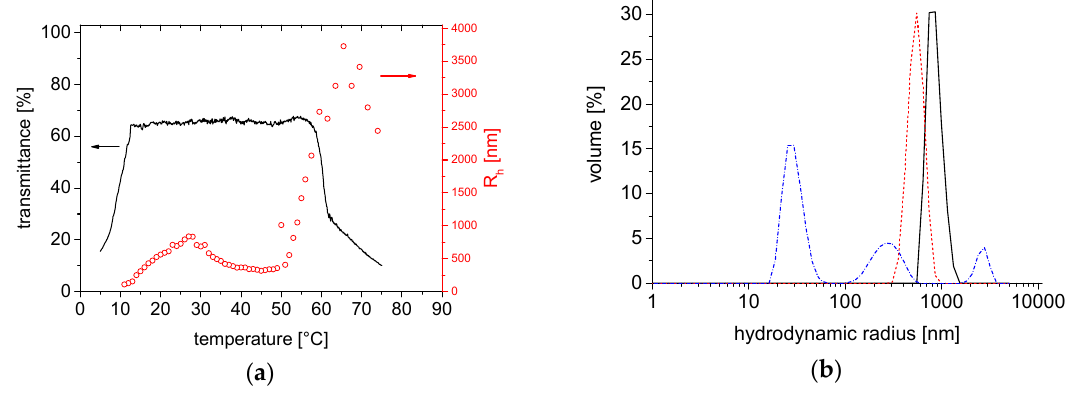
Figure 7. Temperature dependent study (cooling run) of 3.0 g·L − 1 solutions in NSS of ZPE-based block polymer PEG- b -PZPE-1: ( a ) by turbidimetry (cooling run); values for the apparent average hydrodynamic radius R h are also shown ( O ); ( b ) distributions of the hydrodynamic radii at 11 °C ( -·-·-·- ), 35 °C ( - - - - - ), and 75 °C ( — ). For the statistical block copolymer PEG- b -P(SPE- co -ZPE)-1, in which about 20 mol % of ZPE units replace SPE in the zwitterionic block ( cf. Table 2), the thermoresponsive behavior resembles closely that of the block copolymer series PEG- b -PSPE, namely PEG- b -PSPE-1 to PEG- b -PSPE-6. In pure aqueous solution, CP UCST was about 40 °C and thus in an advantageous temperature range, but despite the notable content of ZPE units, the UCST transition is still completely suppressed in NSS. When the ZPE content in the statistical copolymer block is further increased, however, the thermoresponsive behavior seems particularly interesting. For the statistical block copolymer PEG- b -P(SPE- co -ZPE)-2, which contains about equal amounts of SPE and ZPE monomers in the zwitterionic block, an UCST transition is observed in pure water, even though the CP UCST of about 80 °C seems impractically high for most potential uses. However, PEG- b -P(SPE- co -ZPE)-2 also presents an UCST-transition in NSS, with a CP UCST of about 45 °C (Figure 8). This is in the physiologically most interesting temperature window of 30–50 °C.